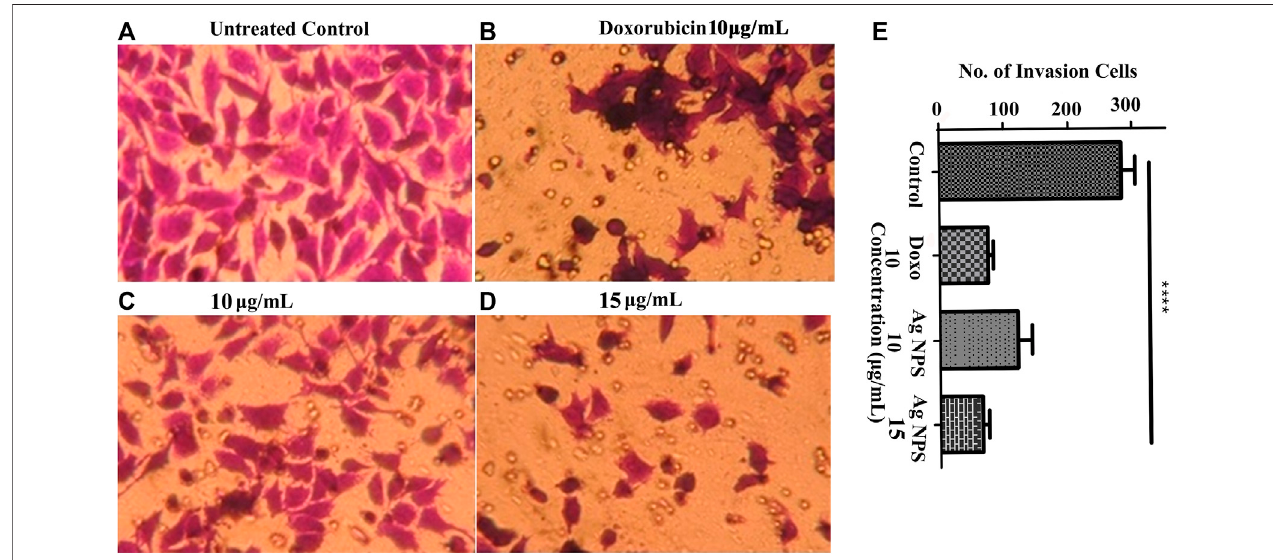
FIGURE8|(A – E) Transwellassaywasperformed toevaluatetheeffect ofAg-NPs oncellinvasion. (A) Untreated controlcells (B) 10 µg/mldoxorubicin (C) 10 µg/ ml Ag-NPs (D) 15 µg/ml Ag-NPs. (E) Bar histogram represents the cell count of cell invasion assay in treated and control.